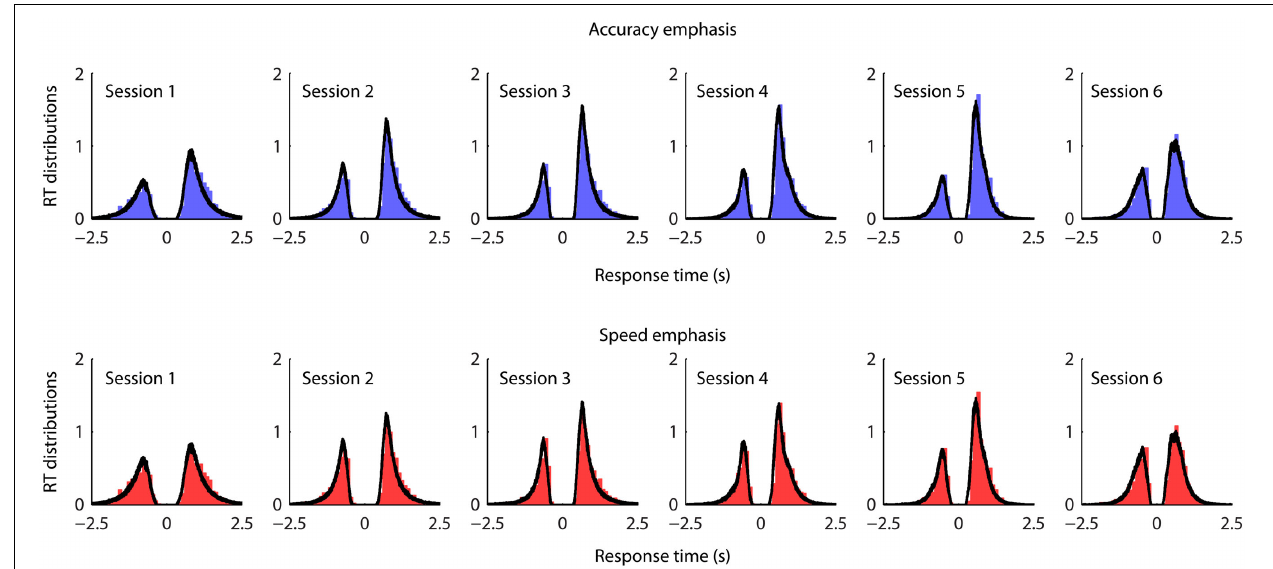
FIGURE 5 | Posterior predictive data distributions for the task conditions and sessions from the best fit model. The distributions along the positive x -axis indicate correct response times, and the distributions along the negative x -axis indicate error response times. Each panel shows the normalized histograms of the observed data (bar plots) and the model prediction (black lines). The area under the curve at positive x -axis is therefore corresponding to the observed and predicted proportion correct. To generate